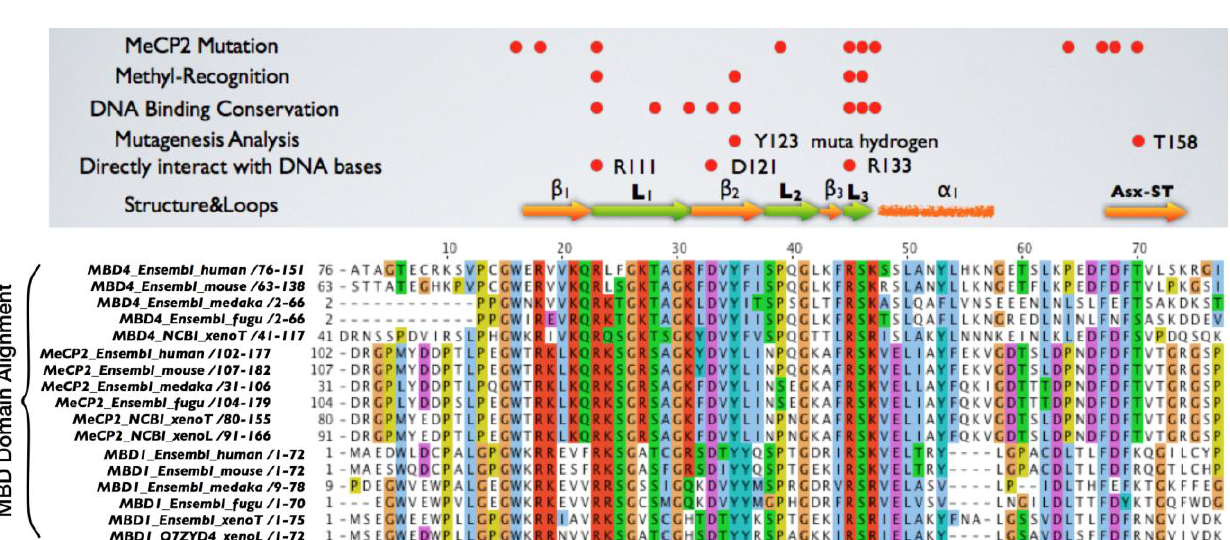
Figure 3. Key functional and structural amino acids are well conserved within MBD domain of MBD4. The MBD domain alignment is shown. A solution structure of the MBDs from MeCP2 and MBD1 has been determined, consisting of four anti-parallel β-strands, two of which were proposed to interact with the major groove of DNA, where a methyl group would be located. In addition, a number of conserved residues throughout the MBD domains of MeCP2 and MBD1 can be easily revealed by alignment, despite their full-length sequences sharing only moderate homology. The MBDs of MBD4, MBD1 and MeCP2 were aligned and compared to indicate essential residues within the MBD of MBD4 that are responsible for binding to methylated DNA sequences. Essential Residues are well conserved in the MBD of MBD4 [93]. In addition, amino acids within the MBD of MBD4 that are important for DNA binding found by mutational analyses and associated with Rett syndrome in MeCP2 are also well conserved. Sequence alignments of the MBD domain of MBD proteins were generated with clustalX module of Jalview